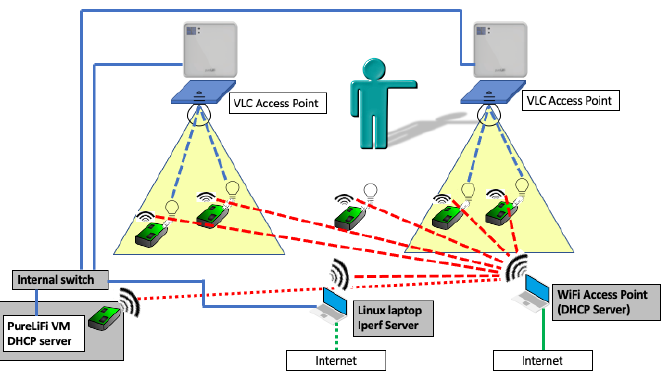
Figure 1. Testbed